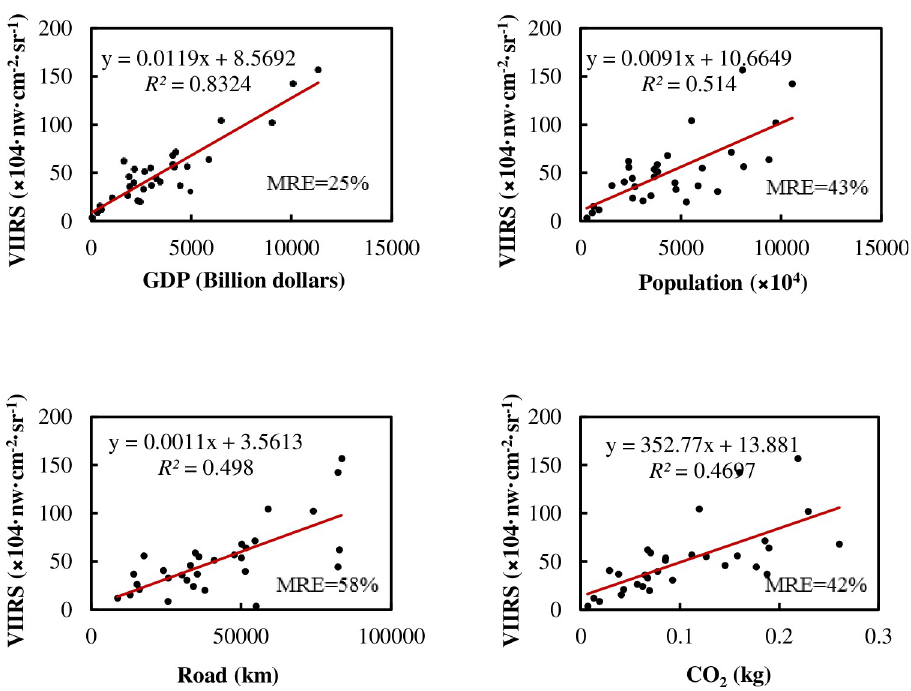
Fig 3. Relationship between total NTL and various elements at the provincial administrative scale in China.